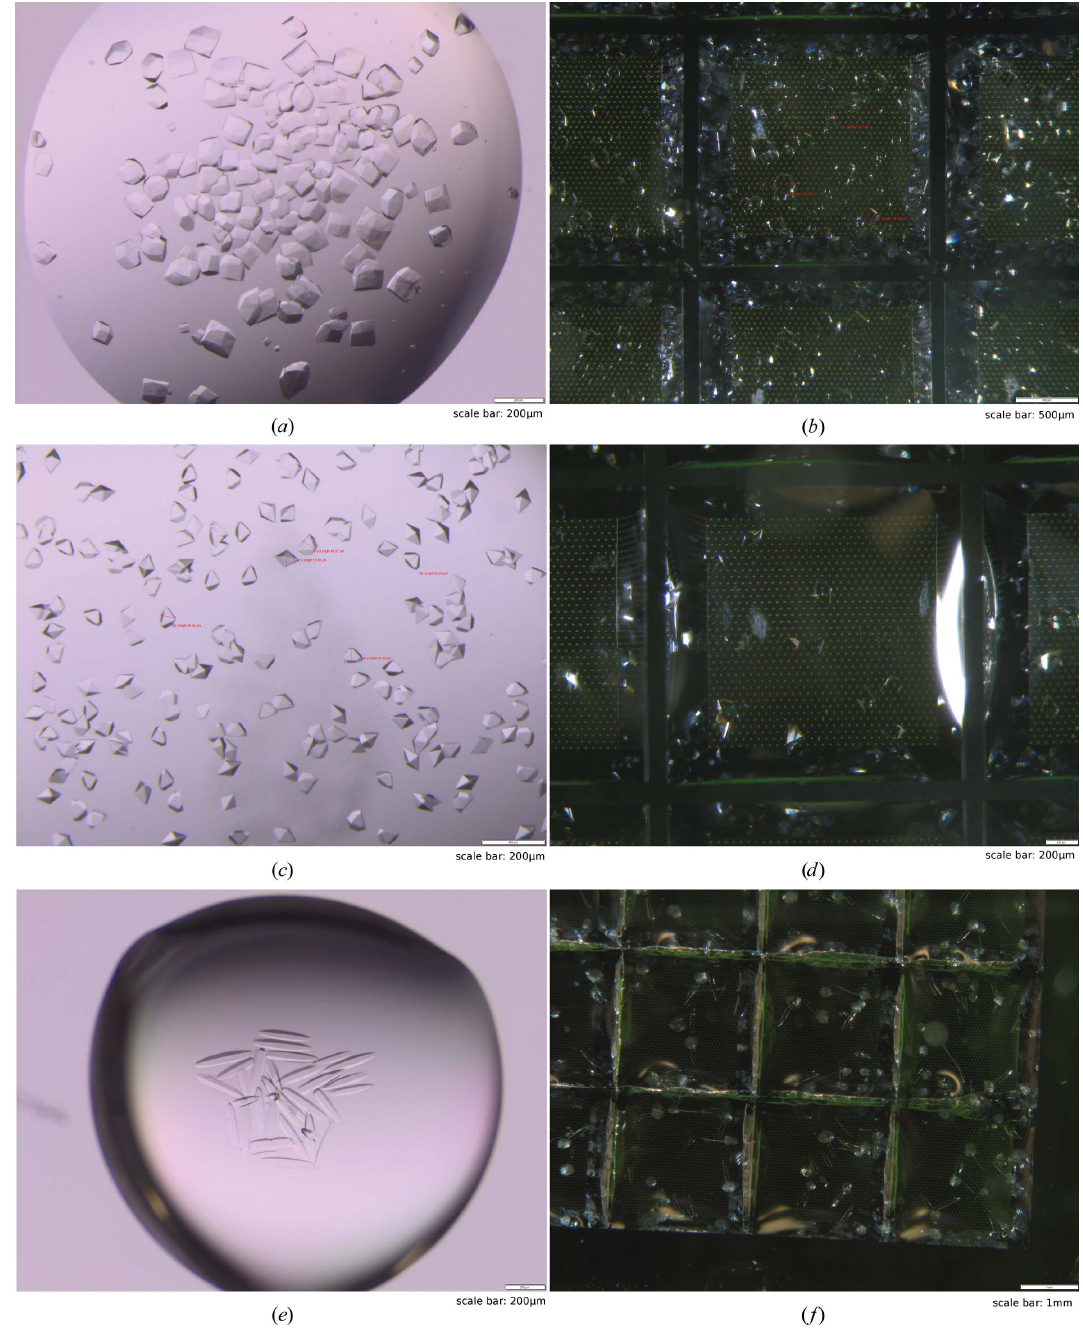
Figure 8 Exemplary images of crystals grown in hanging drops ( a , c , e ) and on Roadrunner II chips ( b , d , e ) using the same crystallization conditions. The crystallization conditions and crystal sizes for lysozyme ( a , b ), proteinase K ( c , d ) and thermolysin ( e , f ) are summarized in Table